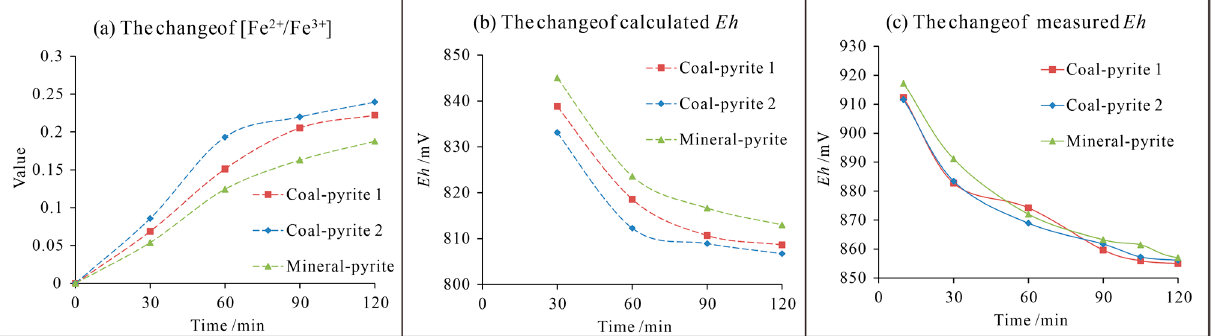
Figure 7. The concentration ratio of Fe 2+ and Fe 3+ and the calculated value and test value of E h : ( a ) is the concentration ratio of Fe 2+ to Fe 3+ ; ( b ) is the calculated value of E h ; ( c ) is the measured value of E h.